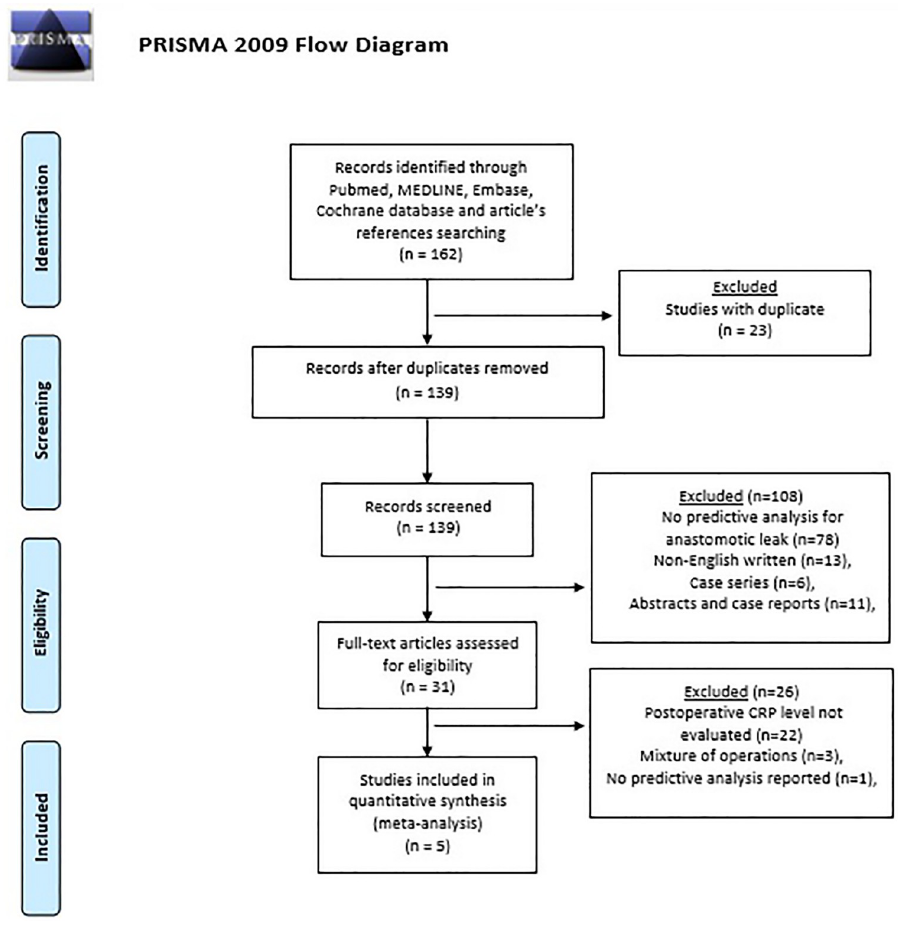
Fig 1. The Preferred Reporting Items for Systematic Reviews and Meta-Analyses (PRISMA)